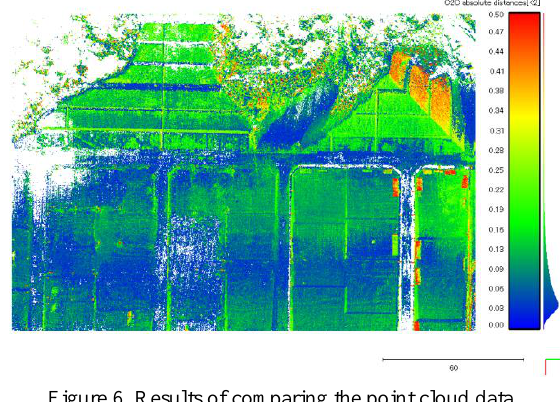
Figure 6. Results of comparing the point cloud